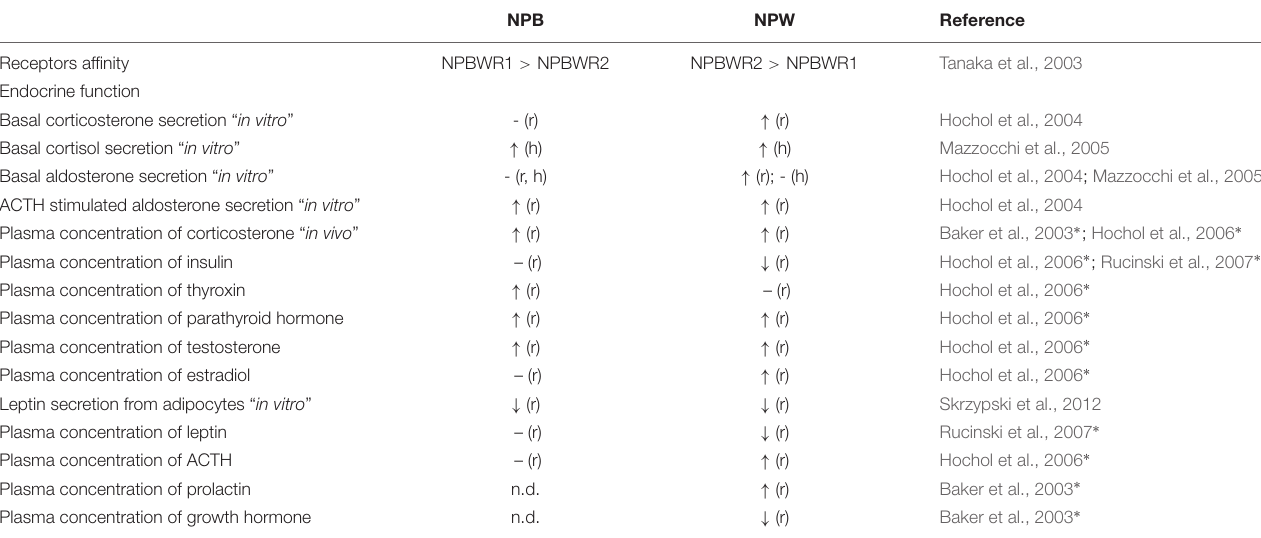
TABLE 5 | Role of NPB and NPW in regulation of endocrine